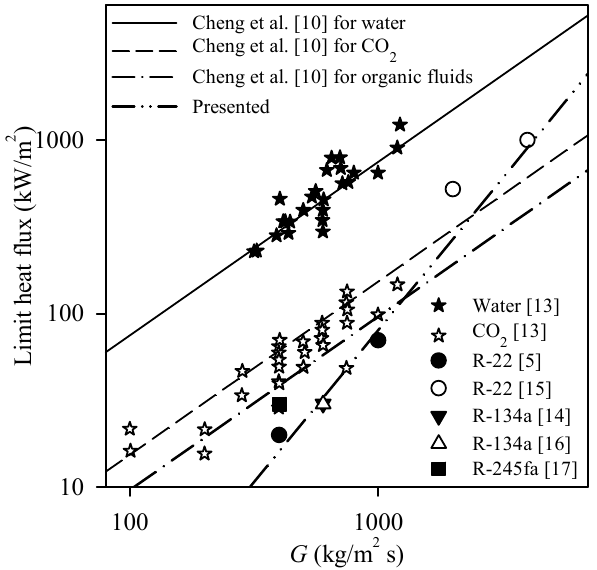
Figure 5. Comparison between experimental LHF and the criterion proposed by Cheng et al. [10]. β Table 4. The ratio of to Cp for water, carbon dioxide, and organic fluids.